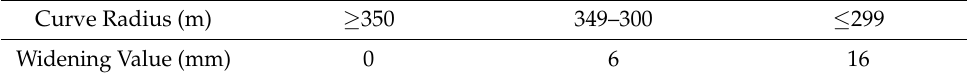
Table 2. Rail gage widening value in the former Soviet Union (after 1961). Curve Radius (m) ≥ 350